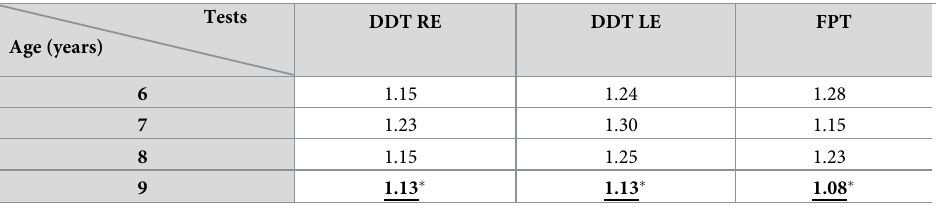
Table 12. Comparison of percentage medians of standard APD results, for all age groups, in